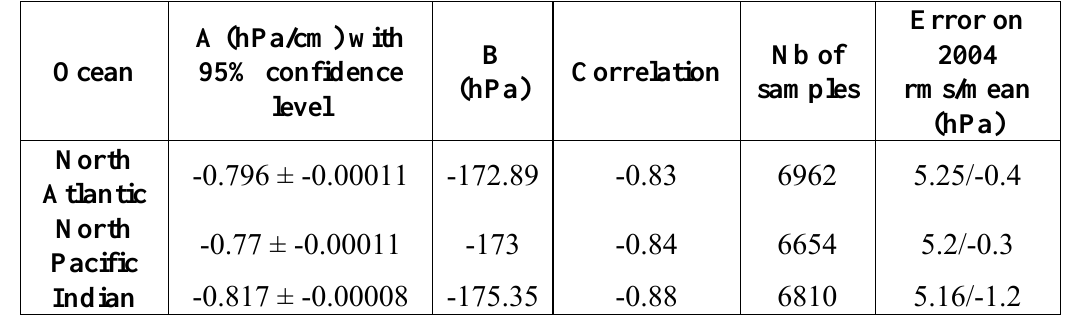
Table 2. SLP-SLA regression models for 2003 extra-tropical